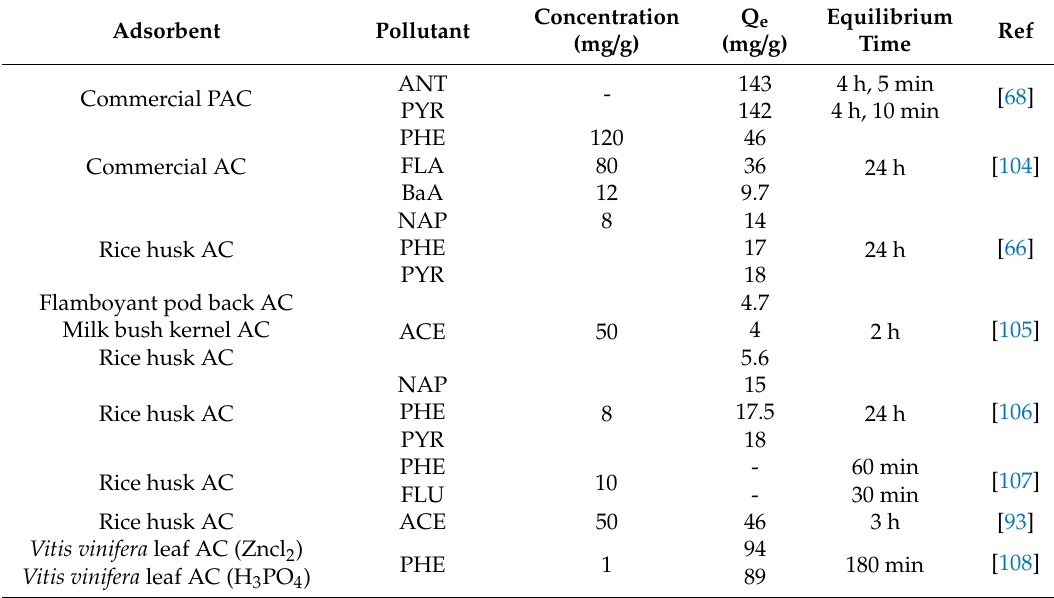
Figure 2. Kinetic studies and adsorption capacities for the removal of NAP and PHE using walnut shell activated carbon (WAC) under ( a ) single and ( b ) binary systems [103]. Copyright: Royal Society of Chemistry (2020). Table 5. Adsorptions of PAHs and phenols using different forms activated carbon (AC) .